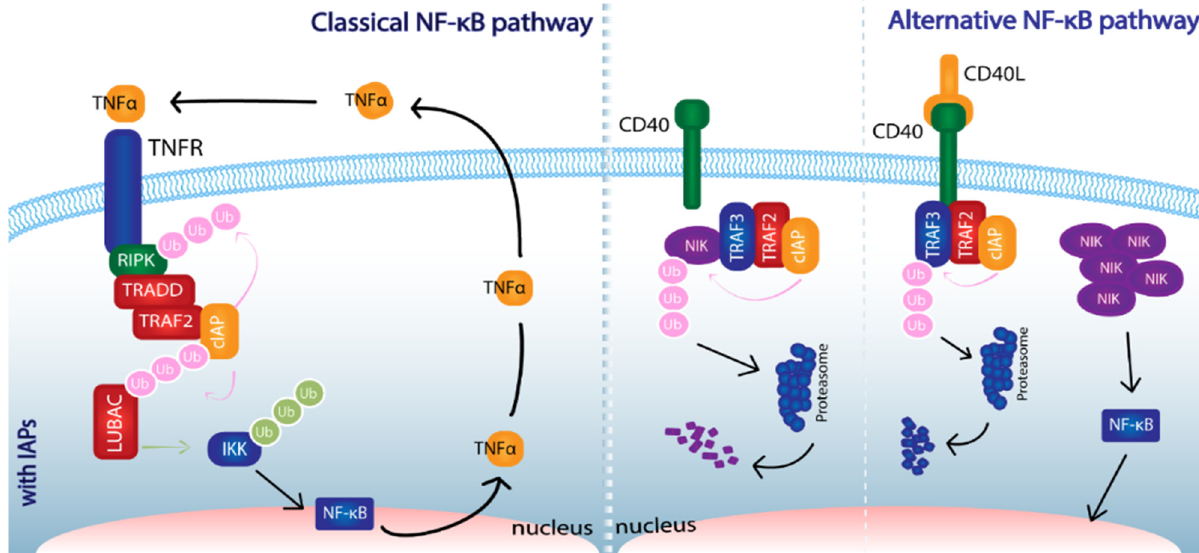
Figure 2. Participation of cIAPs in NF- κ B classical and alternative pathways. E3 ligase activity from IAPs’ RING domain allow the addition of Ub residues onto proteins involved in these signaling cascades. In the classical pathway, cIAPs have a positive regulatory function while they exhibit negative regulation in the alternative pathway. Abbreviations: NF- κ B (nuclear factor kappa-light- chain-enhancer of activated B cells), TNF- α (tumor necrosis factor- α ), RIPK (Receptor-interacting serine/threonine-protein kinase), TRADD (TNF Receptor Associated Death Domain), TRAF (TNF Receptor Associated Factor), cIAP (cellular-Inhibitor of Apoptosis Protein), LUBAC (Linear Ubiquitination Assembly Complex), IKK (I κ B Kinase), NIK (NF- κ B-inducing kinase), Ub (ubiquitin).